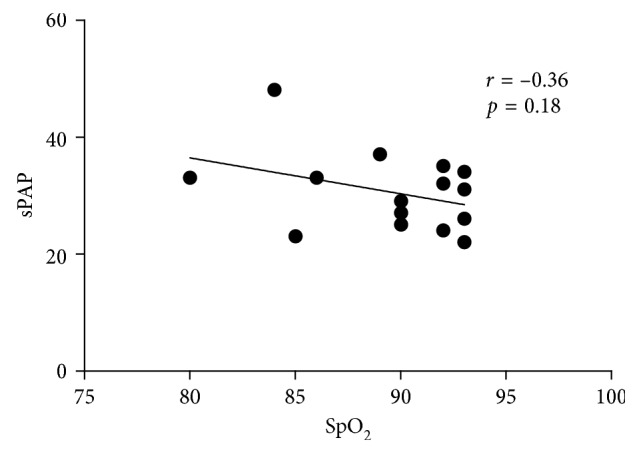
Correlation of sPAP and SpO2 under exertion at high altitude. Each data point corresponds to one subject (CIHH or control). Correlation was not statistically significant.